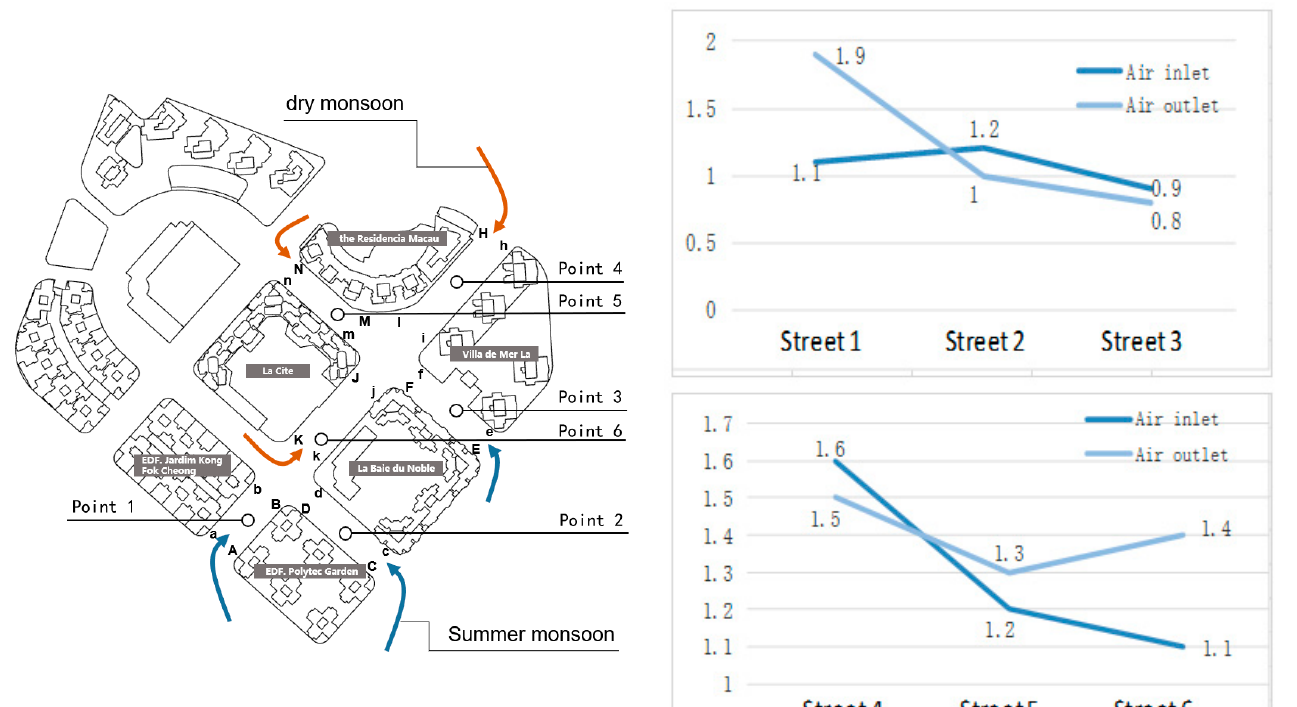
Figure 4. Location of incident flow wind distribution of measuring points and streets (blue is summer monsoon, red is winter monsoon); the change ratio of wind speed in each street during the summer monsoon (street 1 to 3) and winter monsoon (street 4 to 6).